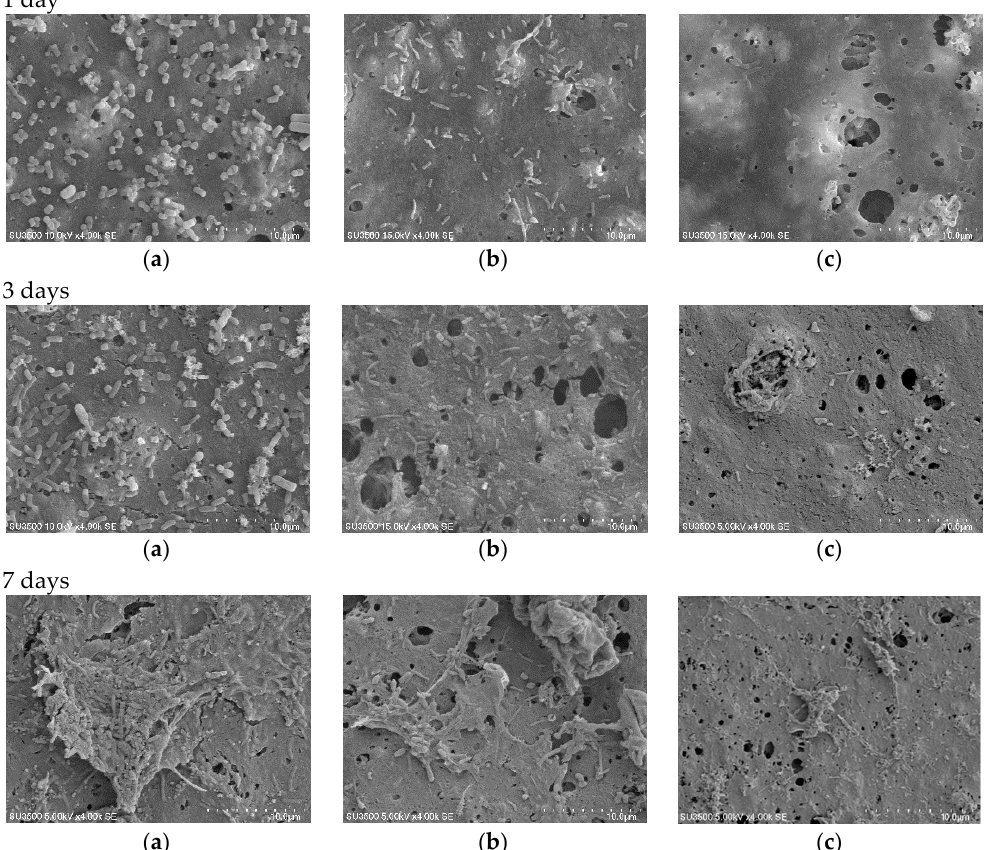
Figure 10. SEM images representing bacterial growth and attachment on ( a ) pure PES; ( b ) PES15; and ( c ) PES30 after immersion in a mixed culture from 1 day to 7 days with 4000× magnification. Scale bar: 10 μ m.